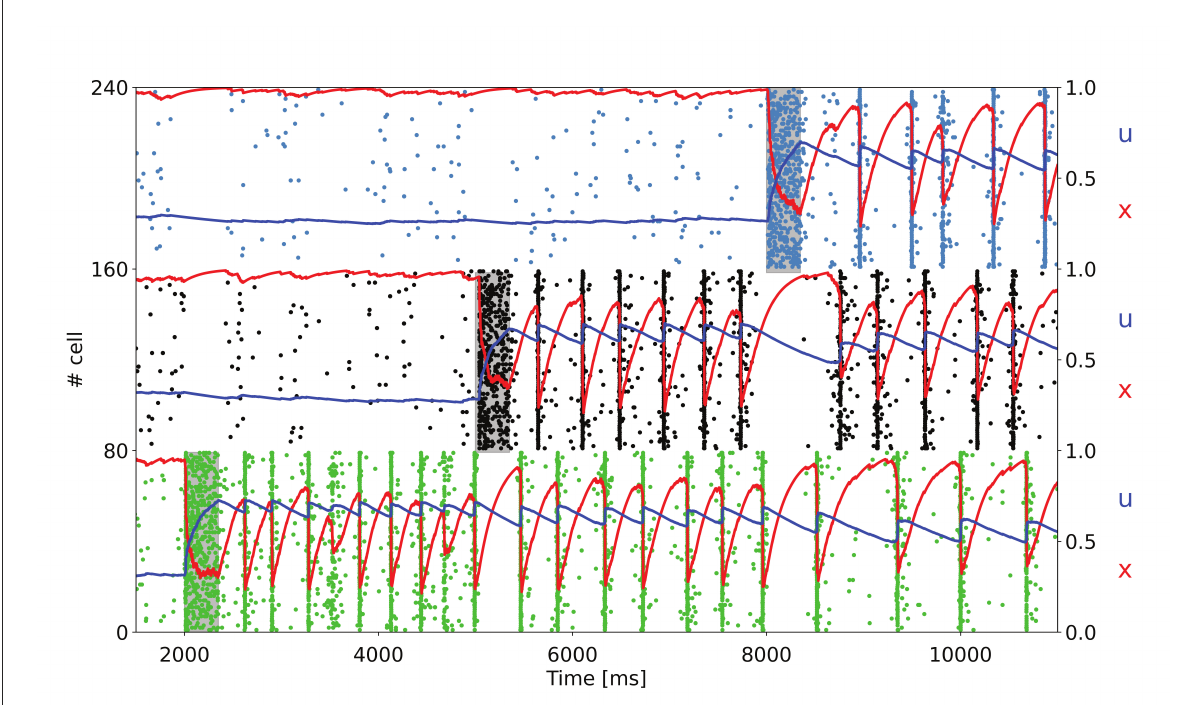
FIGURE4 Raster plot of a subset of neurons of three targeted selective populations when three items are loaded into the network. The network is in the bi-stable regime showing synchronous spiking activity. Item stimuli are loaded into the network at 3,000, 6,000, and 9,000ms.